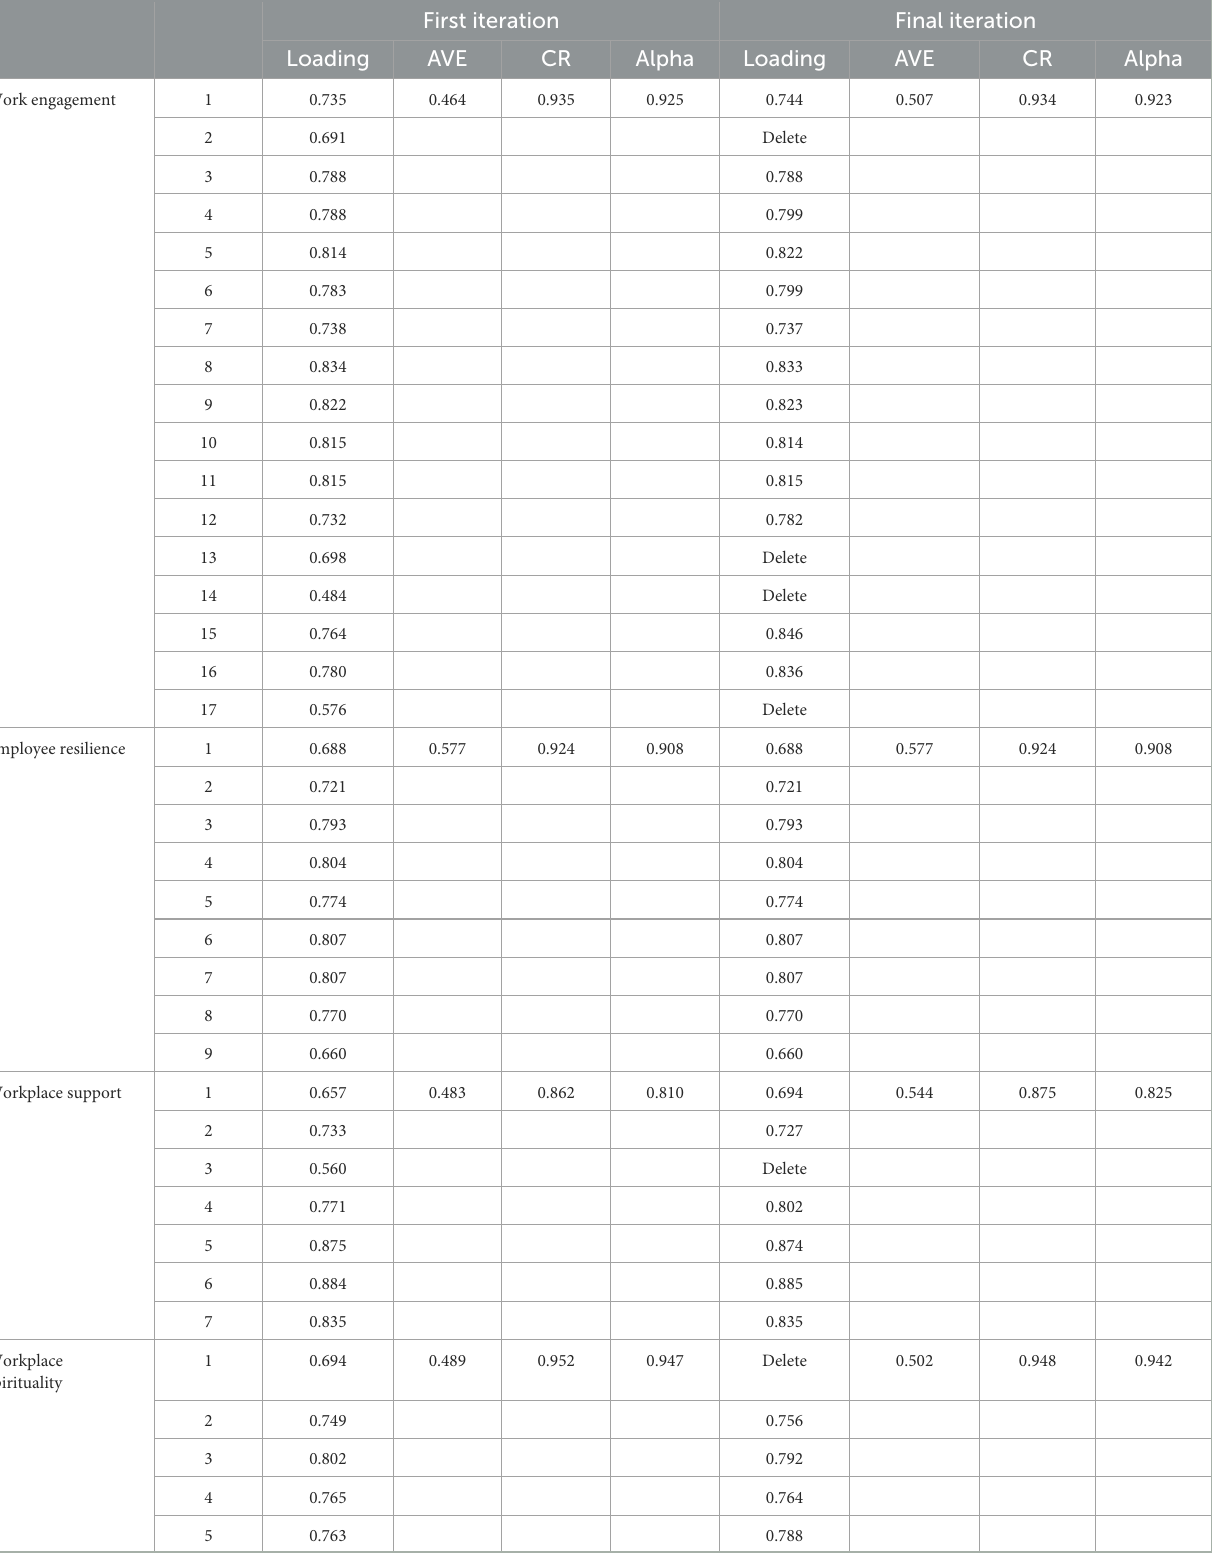
TABLE 1 Measurement model assessments (validity and